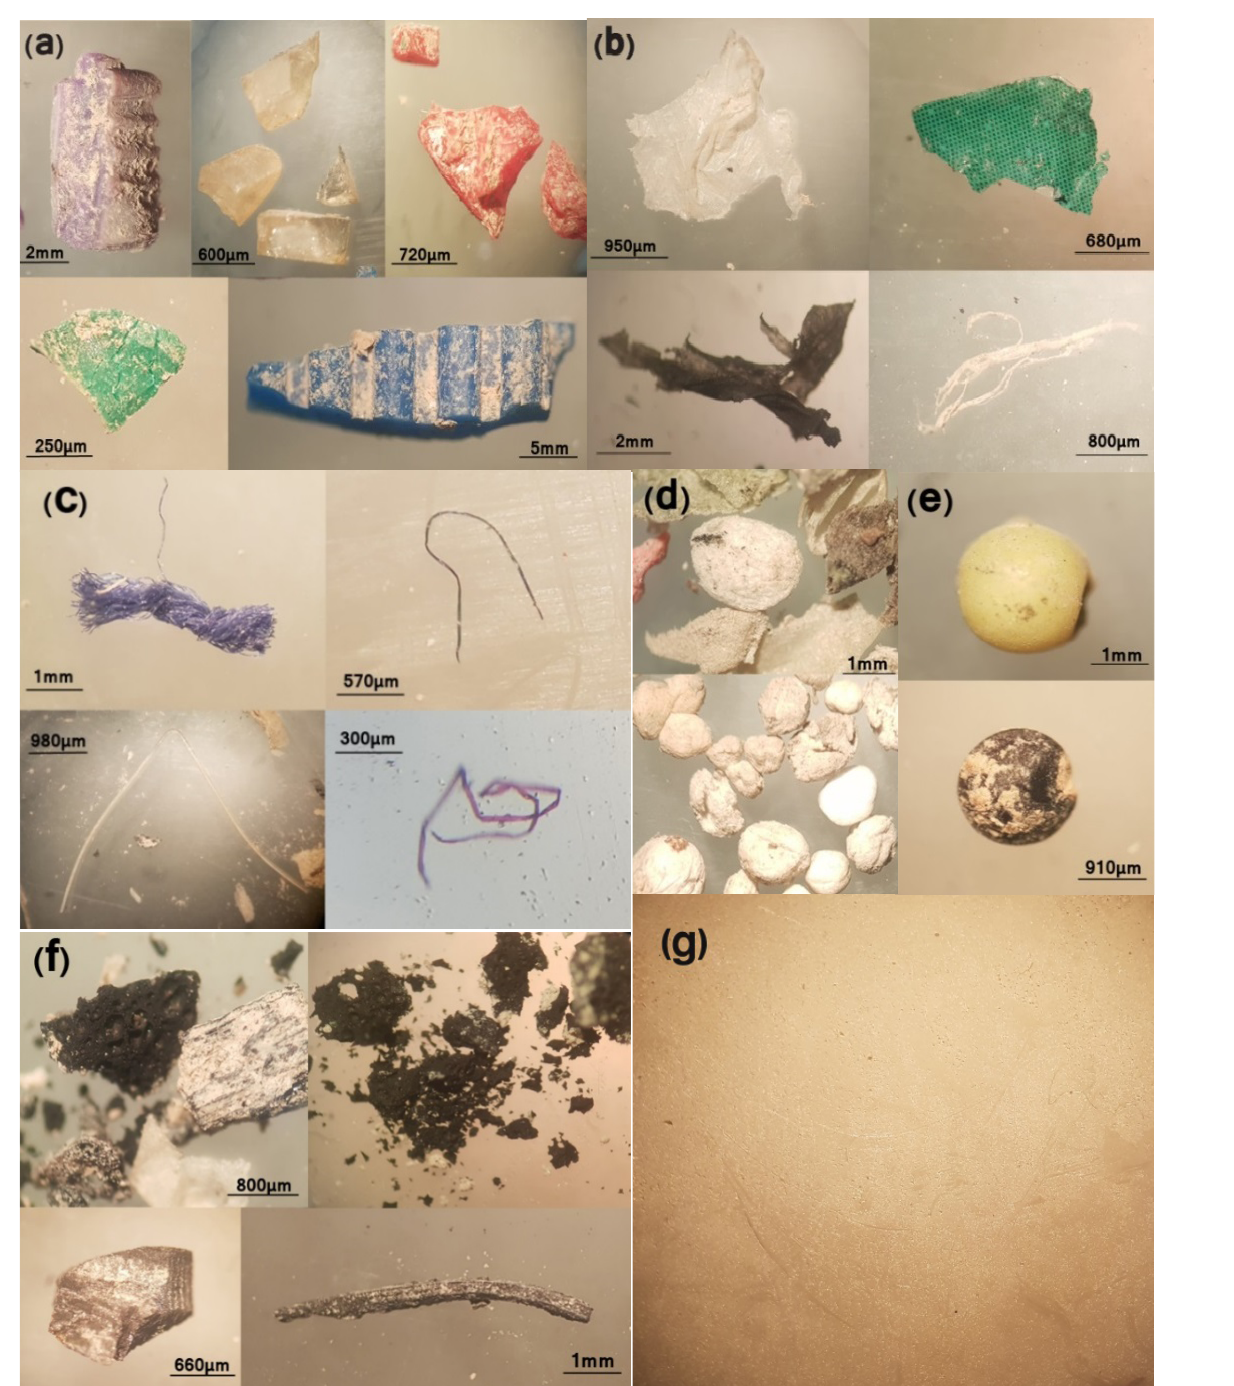
Figure 2. Binocular microscopic images of different types of MPs and MRs (A) Fragmented MPs; (B) Films MPs; (C) Fibrous MPs; (D) Foam MPs; (E) Sphere MPs; (F) Fragmented MRs; (G) Blank sample.